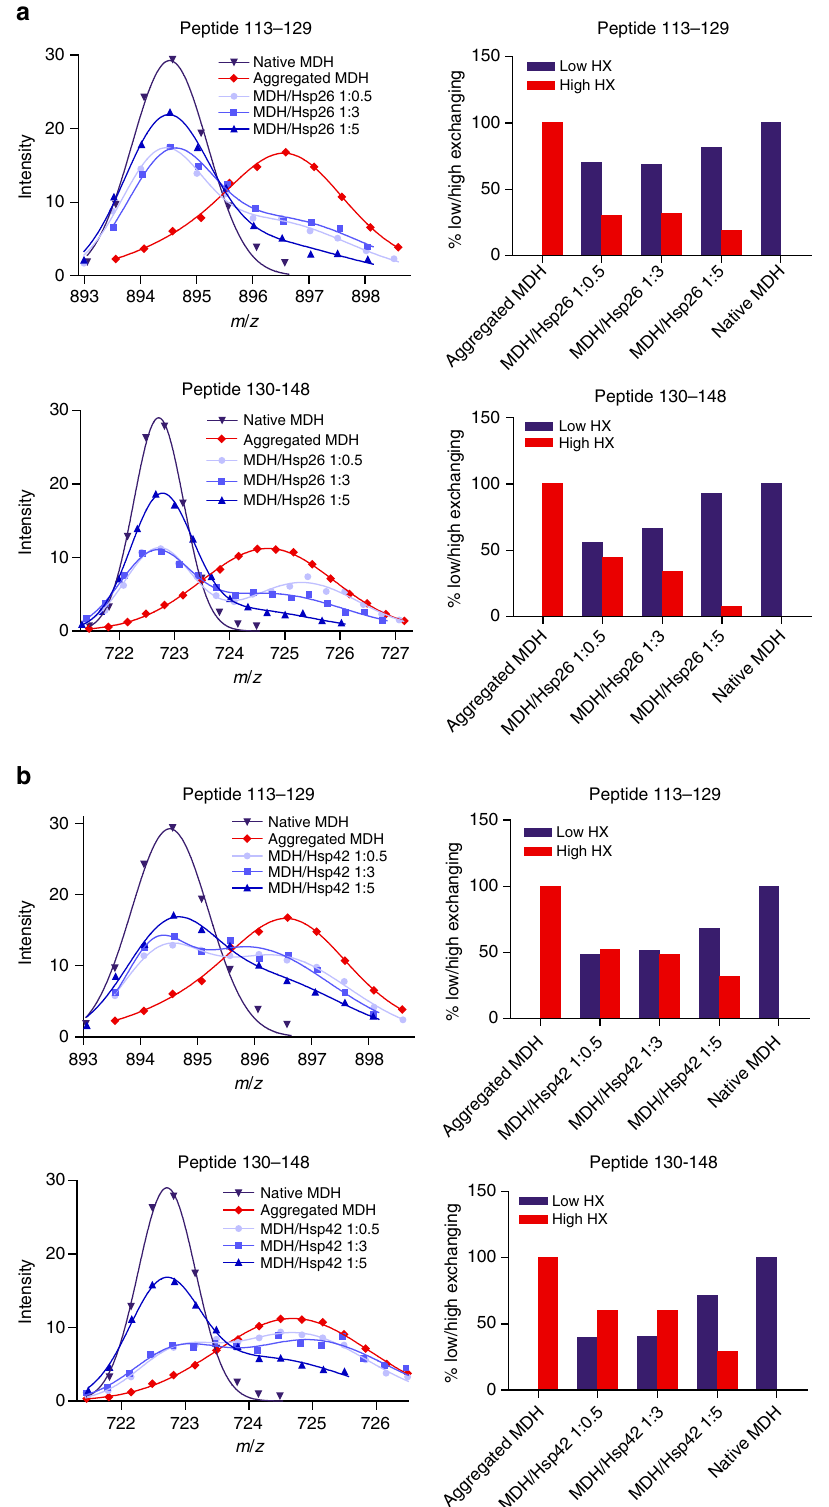
Figure 3 | sHsps stabilize segments of bound MDH in a native-like state. Bimodal distribution of isotope peaks of indicated MDH peptides derived from MDH/Hsp26 ( a ) and MDH/Hsp42 ( b ) complexes. Left panels: Intensity versus m / z diagrams for different peptic MDH fragments after 30s HX at 30 (cid:2) C. Right panels: Fractions of native-like and aggregate-like populations calculated for respective peptides. NATURE COMMUNICATIONS|7:13673|DOI: